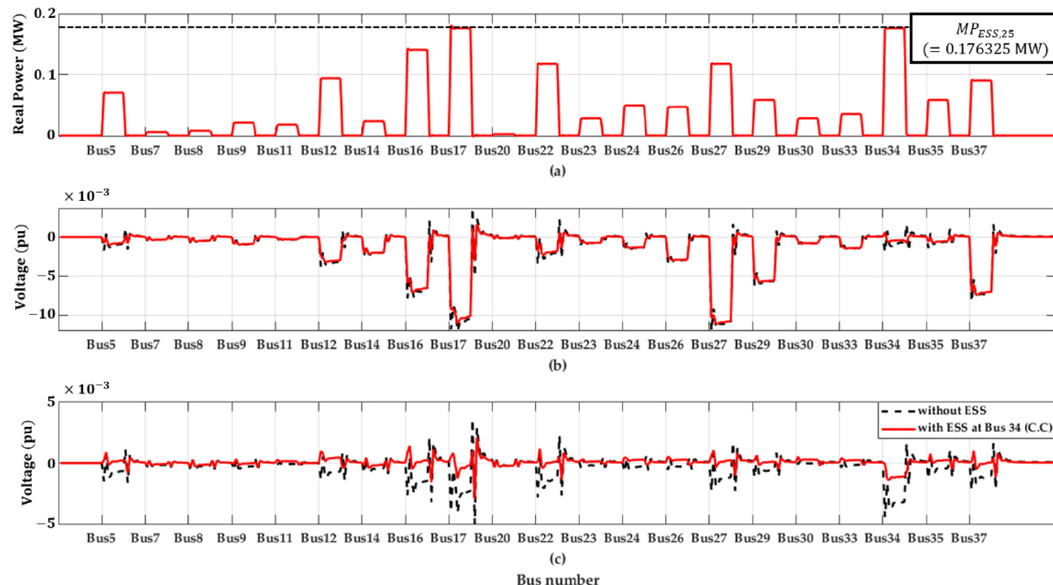
Figure 5. With ESS at bus 34, ( a ) real power response of ESS, ( b ) voltage deviation change at bus 25, and ( c ) voltage deviation change at bus 34 during the VMS operation. C.C, comparison case.